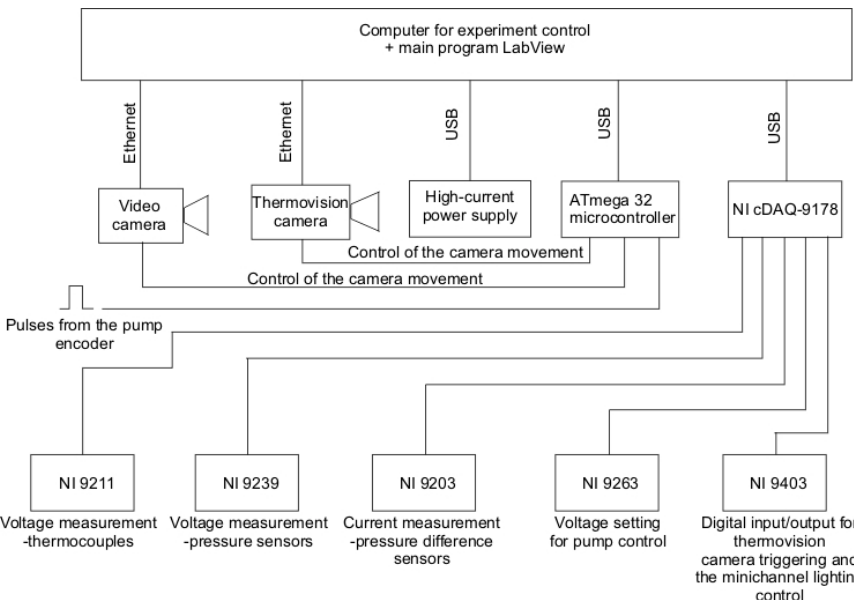
Figure 4. The block diagram of the experimental stand control system.